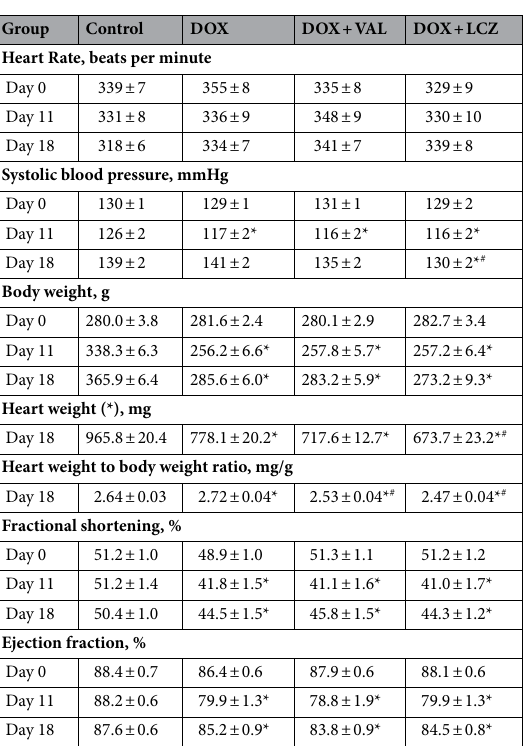
Table 1. Change in the heart rate, blood pressure, body weight, heart weight, heart weight to body weight ratio, fractional shortening, and ejection fraction in the treated rats. Data are expressed as the mean ± SEM. DOX, doxorubicin; VAL, valsartan; LCZ, LCZ696. n = 15 in each group. * p < 0.05 versus control and # p < 0.05 versus